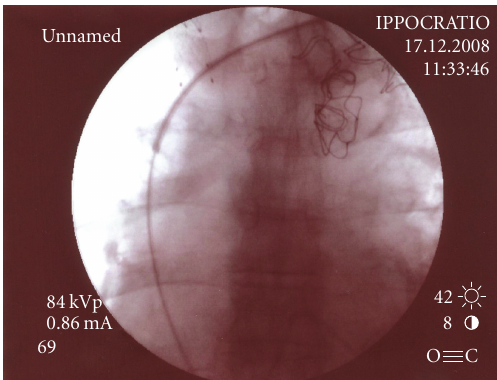
Figure 1: Complete obstruction of the right subclavian vein during venography.